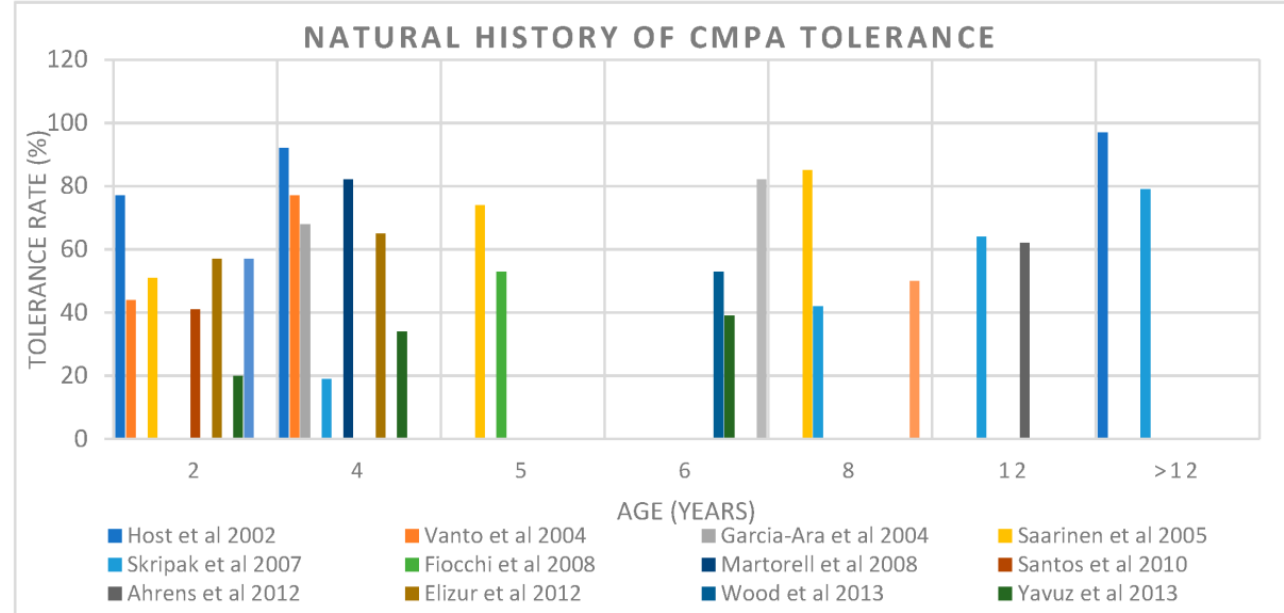
Figure 1. Natural History of CMPA tolerance according to age across studies [18,21–31]. Dietary avoidance limits the symptoms of CMPA, and it is also part of the diagnostic work up of all patients with suspected CMPA. For patients who experienced life-threatening events, this approach would be considered the “common sense” approach, but because the clinical picture related to CMPA can vary, most patients present with vague symptoms and unclear clinical history, requiring a trial of CM avoidance to confirm the